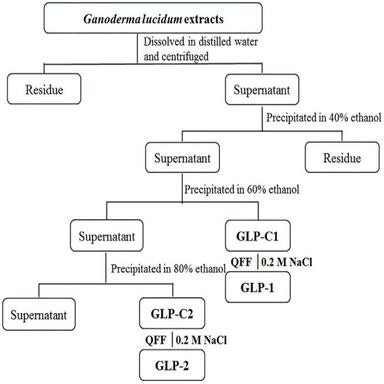
Separation and purification of two G. lucidum polysaccharides.